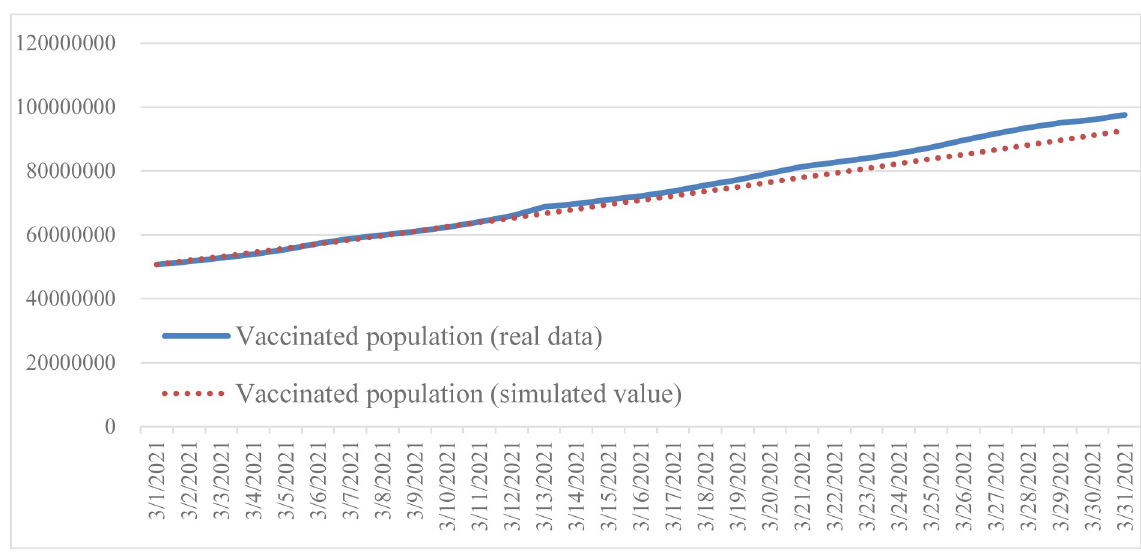
Fig 2. Comparison of reported vaccinated population and simulated vaccinated